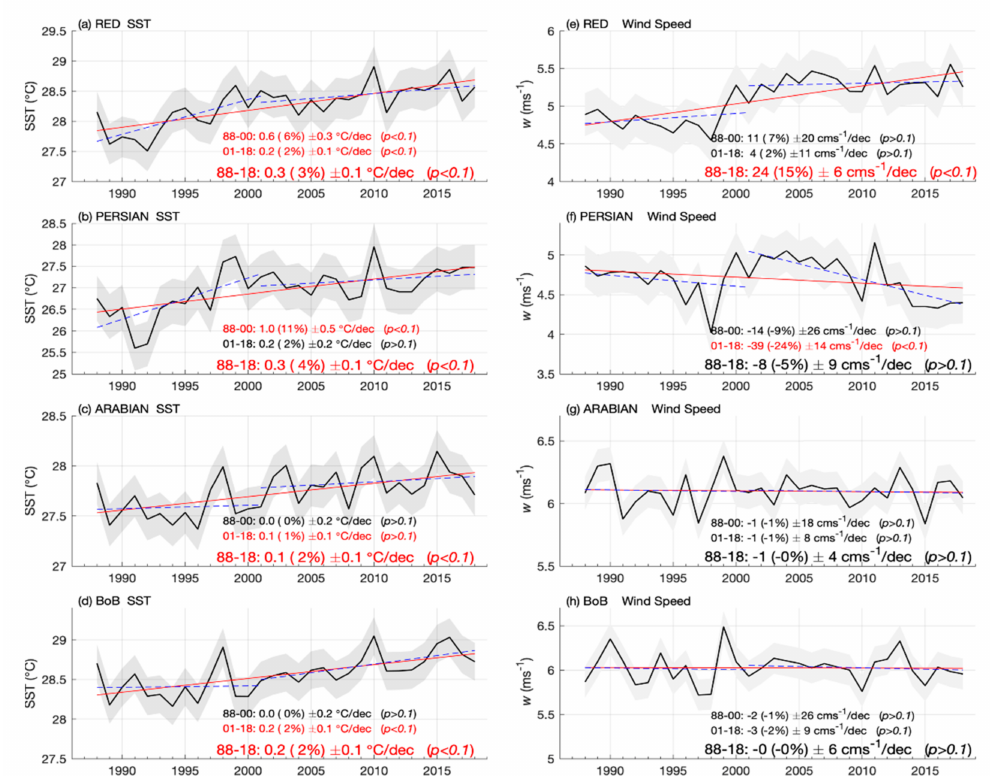
Figure 14. Basin-averaged annual time series (black line) of ( a – c ) SST and ( d – f ) wind speed for the North Indian Ocean marginal seas. ( a , e ) RED: the Red Sea. ( b , f ) PERSIAN: the Persian Gulf. ( c , g ) ARABIAN: the Arabian Sea. ( d , h ) BoB: the Bay of Bengal. The shaded area denotes one standard deviation of annual-mean variability. The red line denotes the linear trend over 1988–2018, and the dashed blue lines are the linear trends over 1988–2000 and 2001–2018, respectively. Linear trend estimates for the three periods are listed: 1988–2000 (top line), 2001–2018 (middle line), and 1988–2018 (bottom line), colored by red if the trend is statistically significant ( p < 0.1) or by black if the trend is statistically not significant ( p > 0.1). The value in the parentheses is the percentage